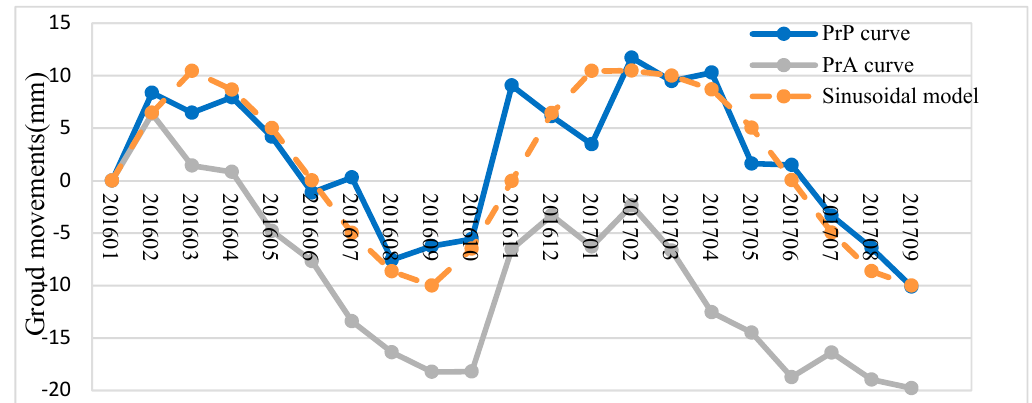
Figure 5. Displacement time series of the reference point (PrP, blue line) and the reference area (PrA, grey line) near the landslide (Figure 1c). The superimposed dotted curve (orange) and lines (red and green) represent predictions of the sinusoidal and linear models that best match the displacement values, respectively. Each point denotes a 20 m × 20 m pixel.